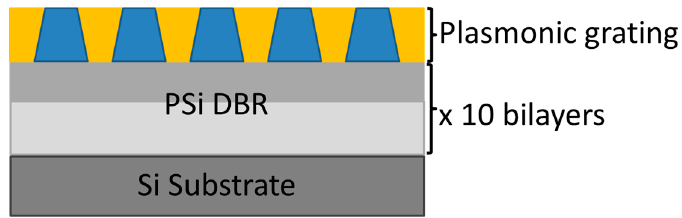
Figure 1. Scheme of the hybrid plasmonic–photonic sample. In the plasmonic grating sketch, the polymeric pillars are colored in blue while the yellow part is gold.